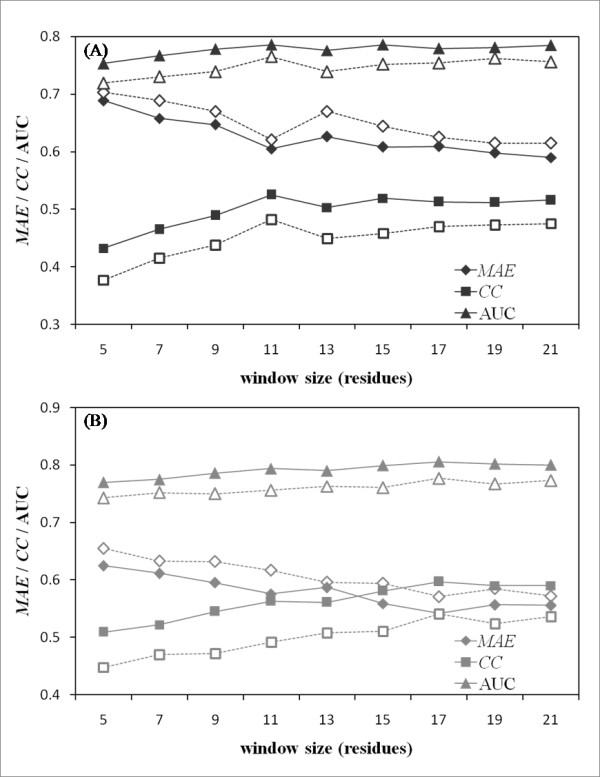
Influence of window size and structural information predictors on prediction accuracy. The respective performances of the proposed method for (A) internal motion and (B) external motion are shown here. The horizontal and vertical axes respectively show the window size and prediction accuracy. Filled symbols represent results obtained with the proposed method using psipred and sable; unfilled symbols signify results of the version that implemented PHD and RVPnet. The AUCs were calculated with a threshold value of 0.